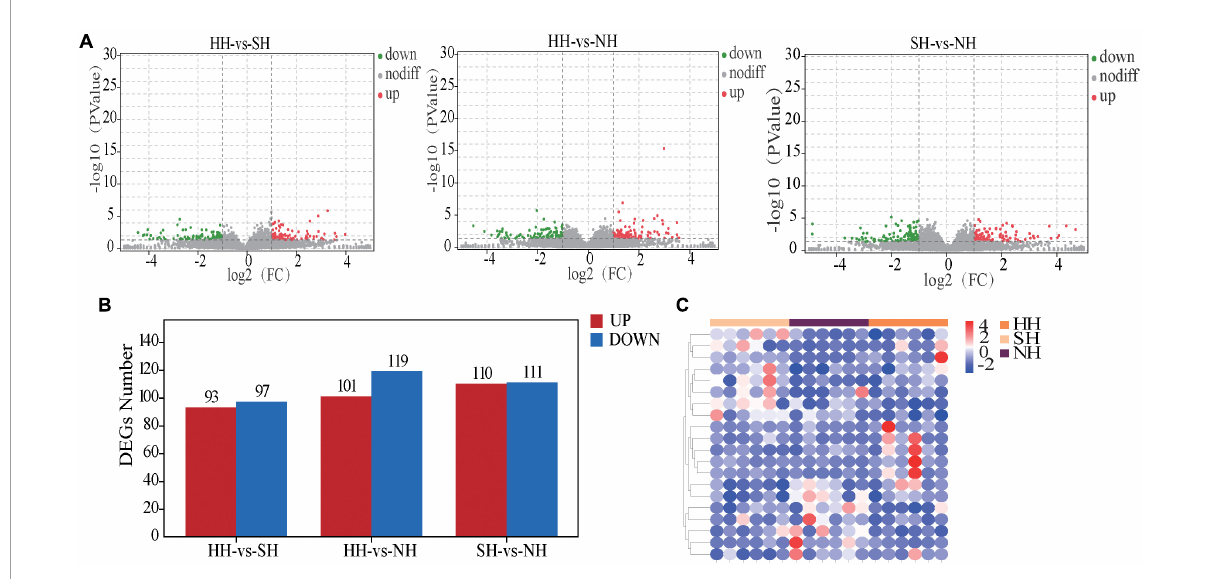
FIGURE1 Transcriptomic comparisons of the longissimus dorsi for the HH, SH and NH sheep. (A) Volcano plots of the DEGs, non-diff: non-differentially expressed genes. (B) Statistical map of the DEGs. (C) Cluster heatmap of the DEGs, red: upregulated genes; blue: downregulated